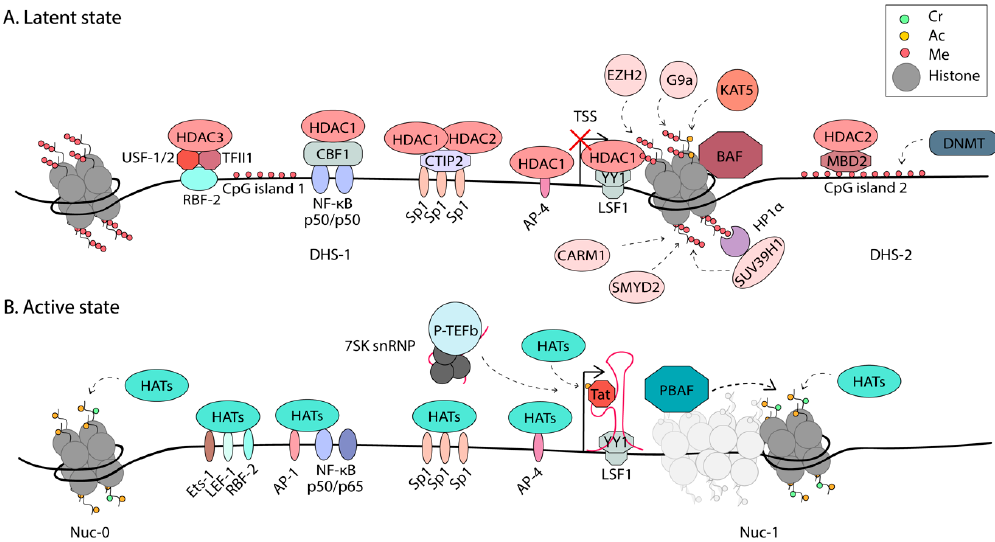
Figure 2. Epigenetic regulation of HIV-1 transcription. This is a simplified overview of some of the factors involved in the modulation of HIV-1 latency. ( A ) Several proteins have been implicated in either the establishment or maintenance of HIV-1 latency. These include TFs, such as RBF2, NF- κ B p50 homodimers, CTIP2, AP-4, and YY1, which directly bind to DNA and serve as docking sites or recruitment factors for other proteins, such as HDACs and HMTs. HDACs remove acetyl groups from the histone tails in nucleosomes. HMTs add methyl groups to histone tails. HMTs involved in HIV-1 latency include the well-established EZH2, G9a, SUV39H1, and the newly associated CARM1 and SMYD2. KAT5 has been recently implicated in histone 4 acetylation at the promoter, associated with HIV-1 latency. The “histone code,” or combination of PTMs (e.g., acetylation and